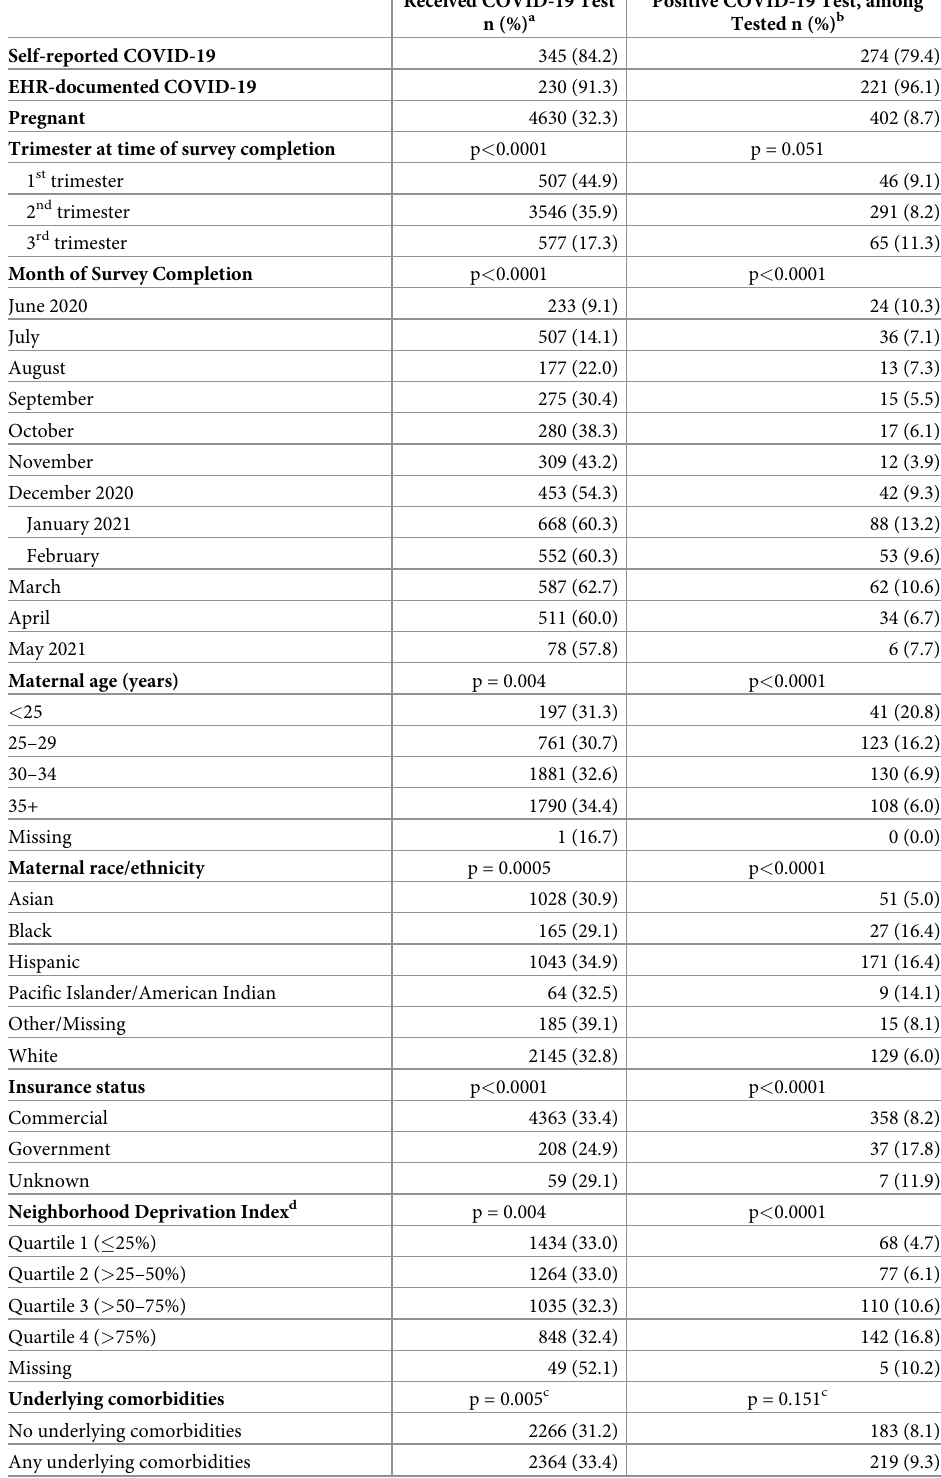
Table 3. Frequency of self-reported receipt of COVID-19 test and test-positivity among women who were cur- rently pregnant at time of survey